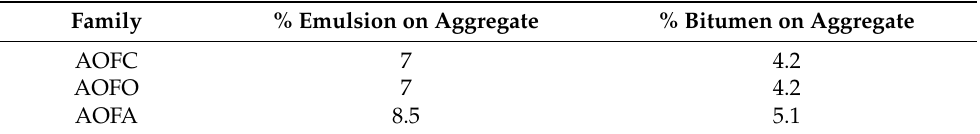
Figure 7. Coating test of bituminous mixtures conformed with ophite coarse and fine aggregate and ophite filler AOFC. ( a ) 6.5% residual bitumen, ( b ) 7% residual bitumen, ( c ) 7.5% residual bitumen. Table 9. Optimum percentage of emulsion and residual bitumen for AOFC, AOFO, and AOFA bituminous mixes.